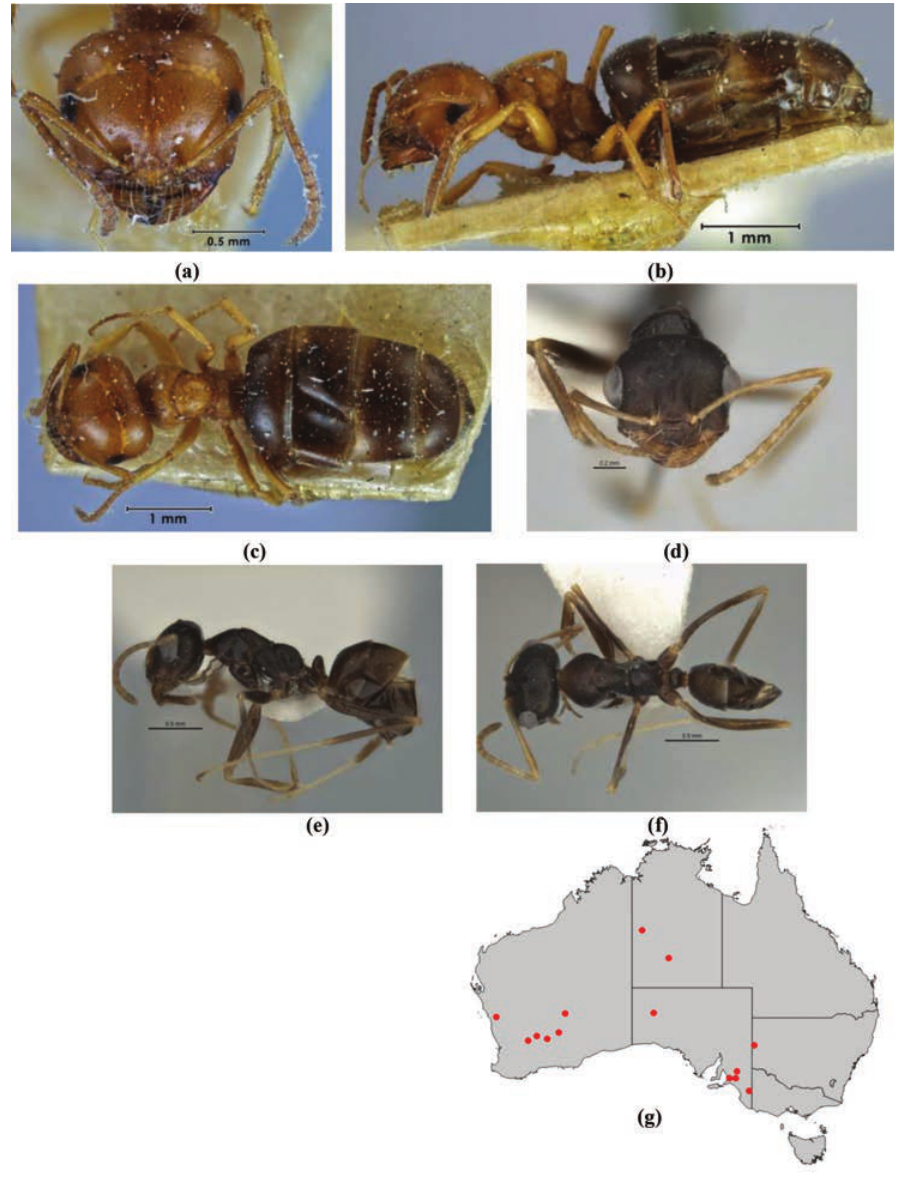
Figure 55. Melophorus fieldi Forel: MHNG major worker syntype frons ( a ), profile ( b ) and dorsum ( c ); non–type minor worker (JDM32-001489) frons ( d ), profile ( e ) and dorsum ( f ); distribution map for the species ( g ). Low resolution scale bars: 0.5 mm ( e, f ); 0.2 mm ( d ). Minor worker description. Head . Head square; posterior margin of head weakly convex; frons matt or with weak sheen, shagreenate; pilosity of frons a mixture of a few well-spaced, erect setae interspersed with appressed setae only. Eye large (eye length